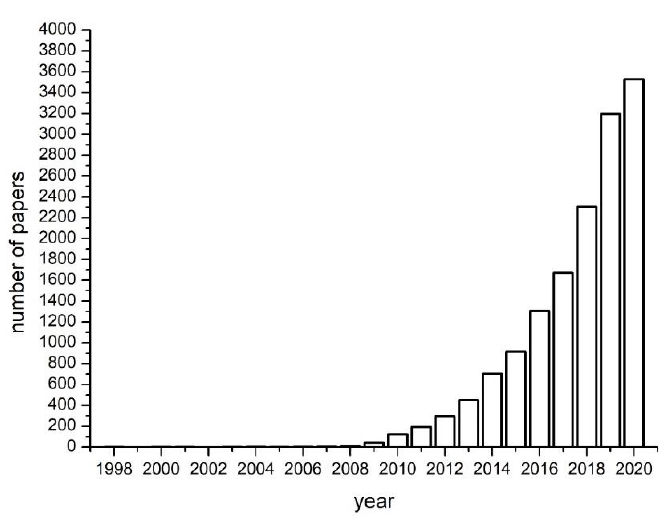
Figure 1. Graph showing the increasing number of papers published in the last two decades. The source of the figures are “Web of Science”, where only the term, “biochar”, was used as a key-word .